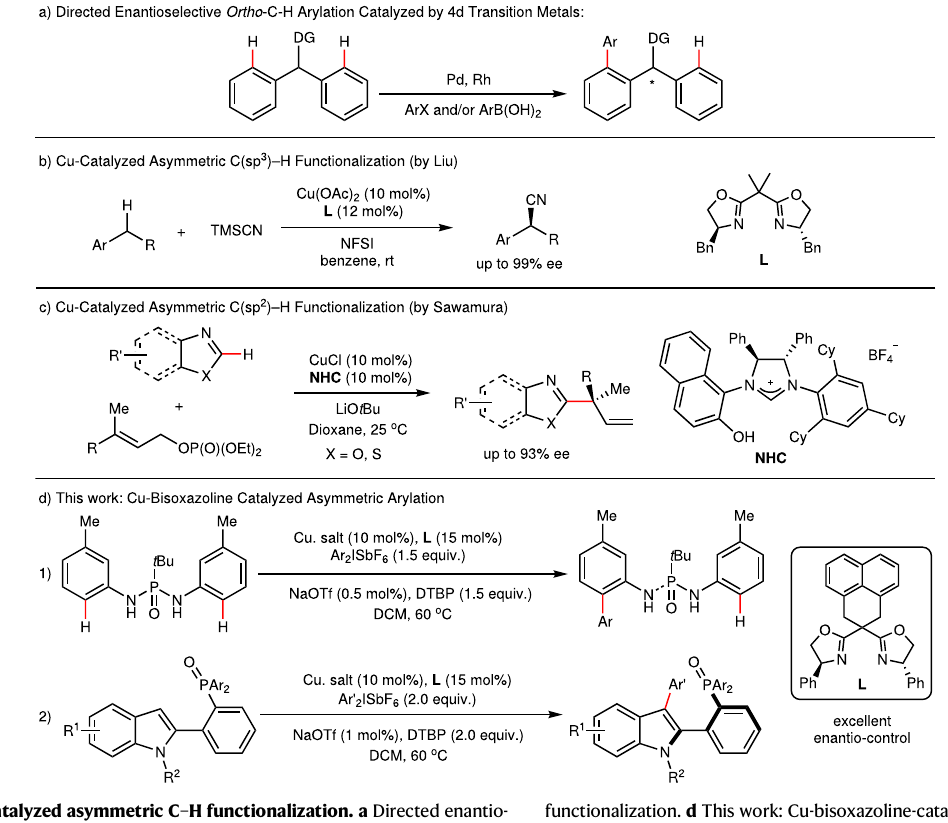
Fig. 1 | Metal-catalyzed asymmetric C – H functionalization. a Directed enantio- selective o rtho -C – H arylation catalyzed by 4d transition metals. b Cu-catalyzed asymmetric C(sp 3 ) – H functionalization. c Cu-catalyzed asymmetric C(sp 2 ) –